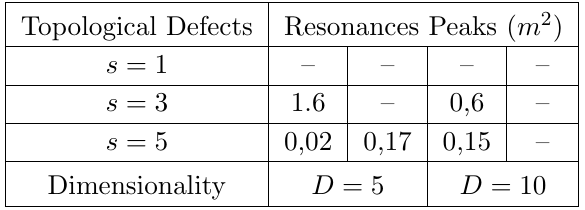
Figure 6 . Potentials U ( z ) and Transmission coe(cid:14)cient T ( m 2 ) for massive left fermions for D = 5 (line) and D = 10 (dotted), with (cid:17) = 1 and s = 1 (a, d), s = 3 (b, e) and s = 5 (c, f) in derivate dilaton setup.